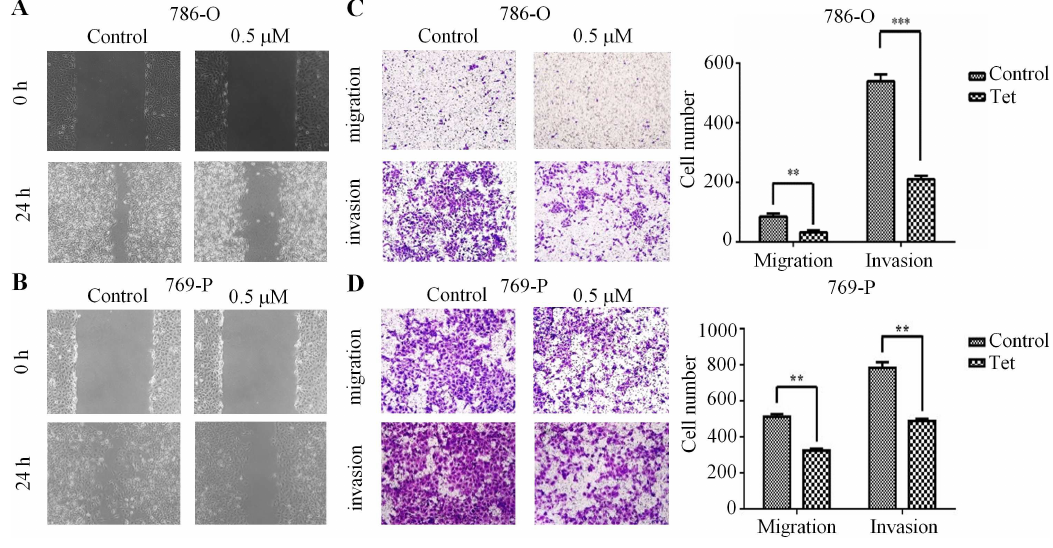
Fig 2. Tet suppressescell migration and invasion of human RCC. The inhibitionof Tet on 786-O ( A ) and 769-P ( B ) cells were determinedby woundclosure assay. The width of scratch was measuredin vehicle or Tet group. 786-O ( C ) and 769-P ( D ) cells were treated with vehicleor Tet for 24 h using the Transwell migration and invasionassay. The quantitative data were shown in the right panel. The values were showedas mean ± S.E. All the experiments were performed in triplicate ( ** means P < 0.05, *** means P <